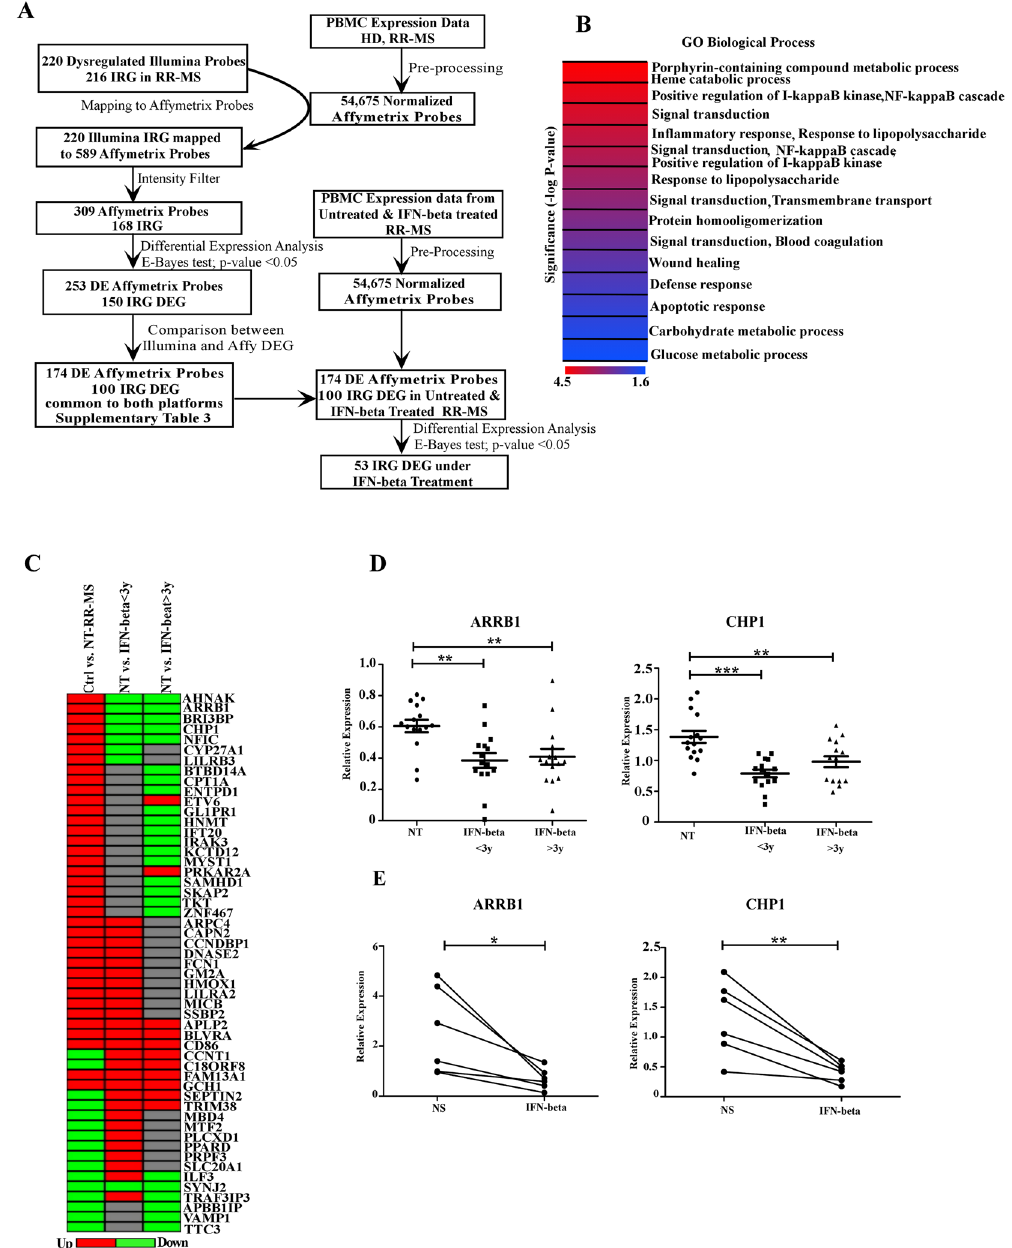
Figure 3. ( A ) Flow chart for the human PBMC transcriptomics studies in RR-MS. ( B ) Significant Gene Ontology terms relative to the 100 validated IRG DEG in RR-MS. ( C) Fold change heatmap representing the dysregulated IRG at baseline in RR-MS (first column) which are targeted in vivo by IFN-beta treatment (second and third columns). ( D) ARRB1 and CHP1 transcript levels in PBMC from a novel independent cohort of untreated (NT) RR-MS and IFN-beta treated RR-MS as detected by quantitative PCR. ** p-value < 0.01, *** p-value < 0.001 ( E) ARRB1 and CHP1 transcript levels in PBMC from RR-MS subjects stimulated in vitro in absence (NT) or presence of IFN-beta, * p-value < 0.05, ** p-value <